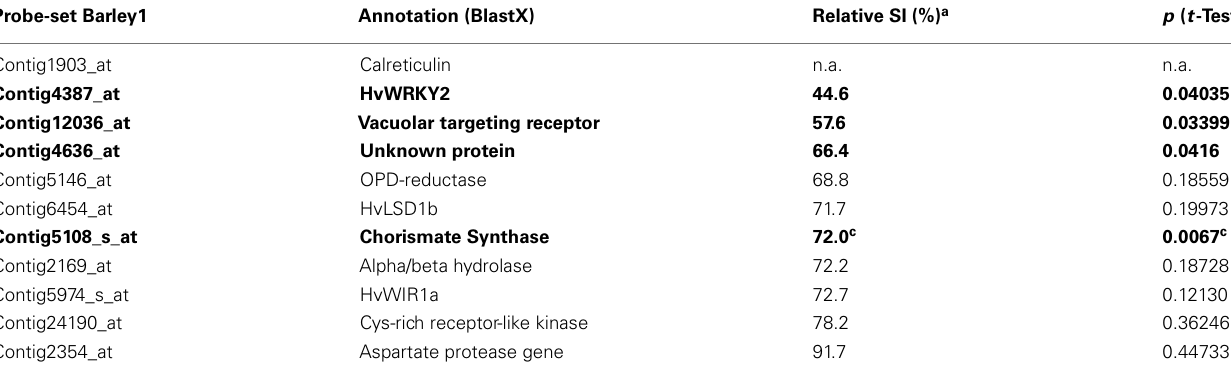
Table 4 |TIGS of CGs significantly associated with resistance to Bgh